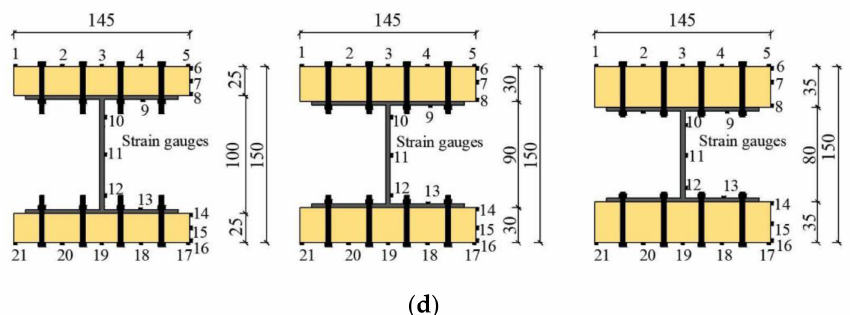
Figure 2. Loading device and layout of measuring points (unit: mm): ( a ) photo of the loading device; ( b ) loading device and dial indicator arrangement; ( c ) arrangement of strain gauges on the top and bottom boards of specimens; ( d ) arrangement of strain measurement points for mid-span